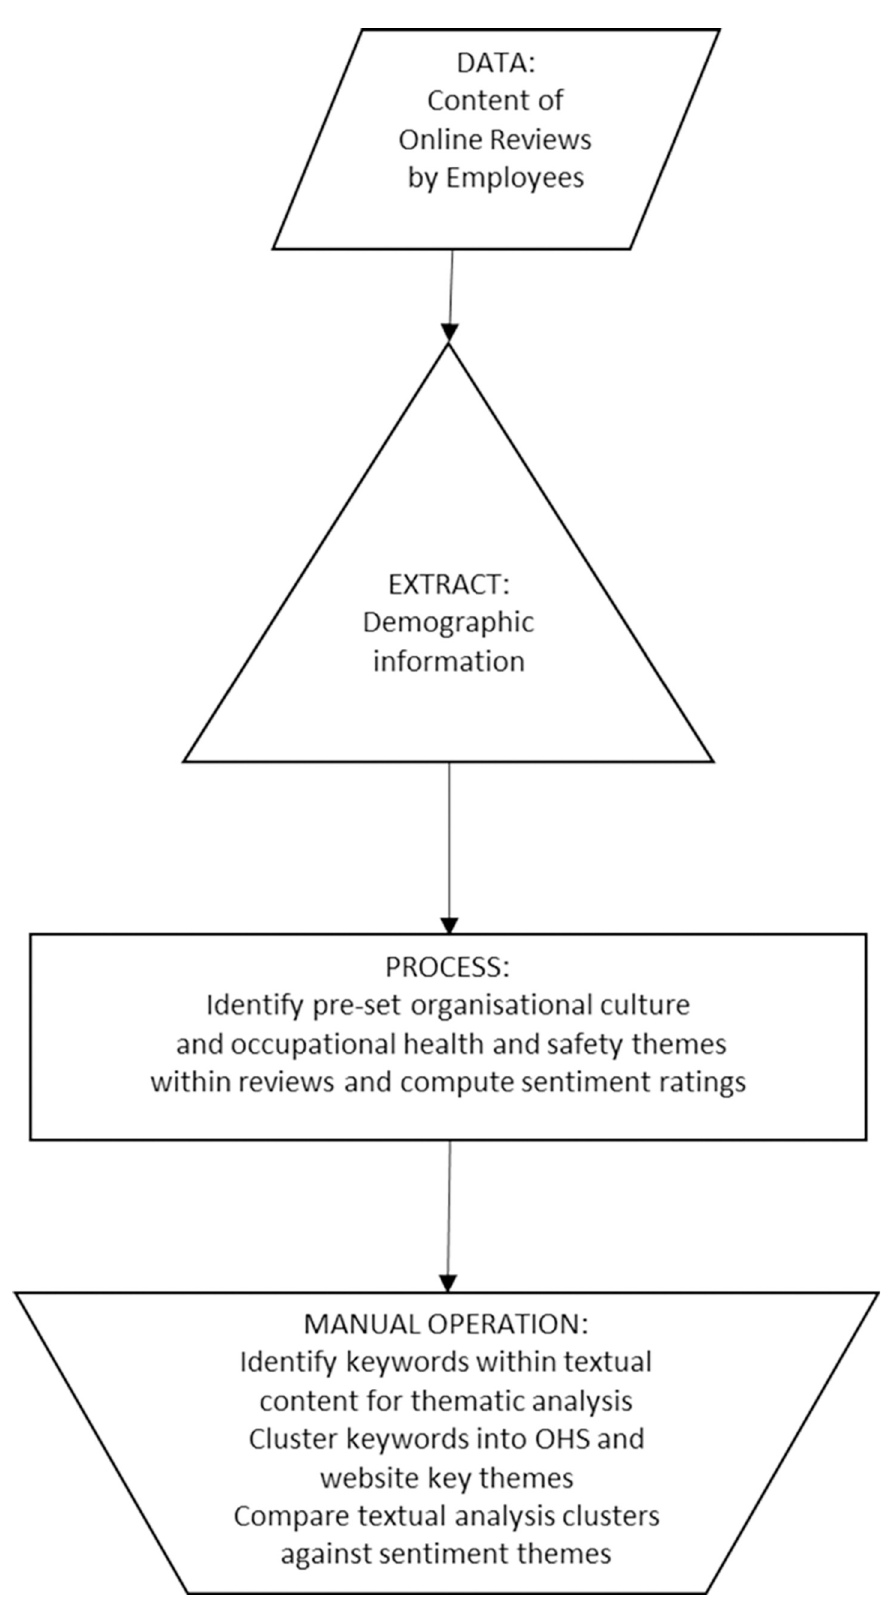
Fig 1. Methodology for assessing and categorising content from hospital employee online reviews. https://doi.org/10.1371/journal.pone.0274074.g001 PLOS ONE | https://doi.org/10.1371/journal.pone.0274074 September 14,